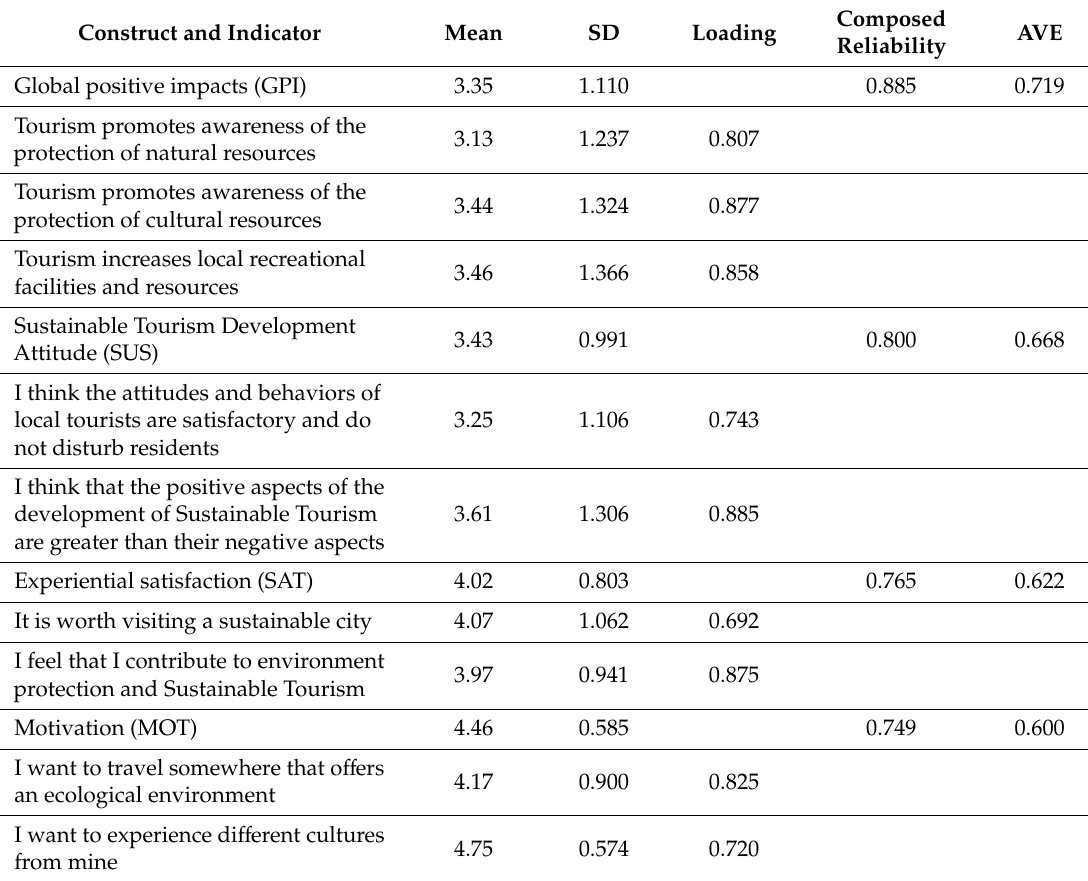
Table 2. Mean, standard deviation, individual reliability, composed reliability and average variance extracted for constructs and